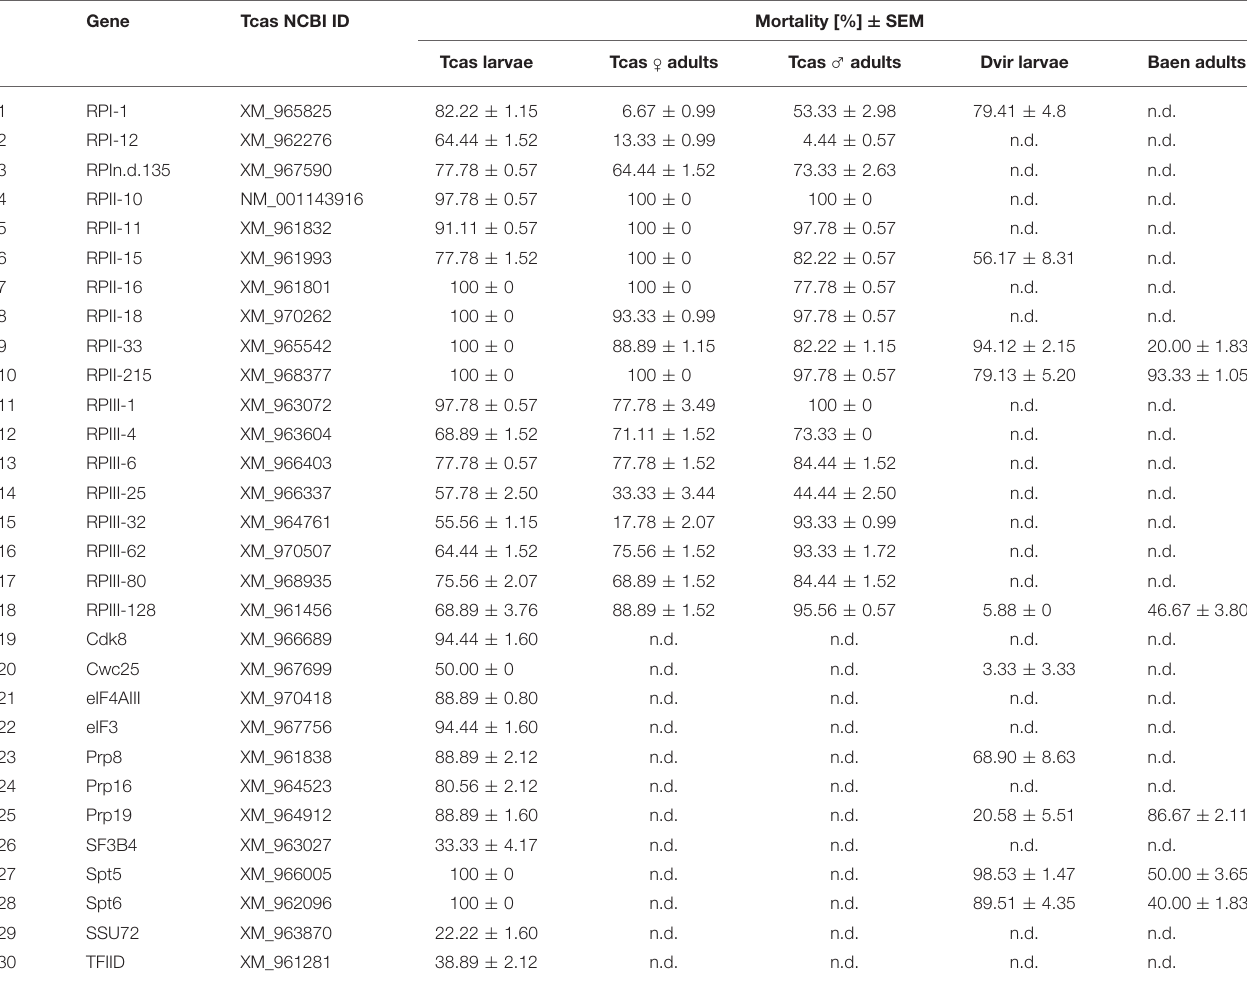
TABLE 1 | Mean mortality (standard error % mortality in three replicates of bioassays) of 30 dsRNA targets 10 dpi in T. castaneum (Tcas), 9 dpf in D. v. virgifera (Dvir) and 10 dpi in B. aeneus (Bean).